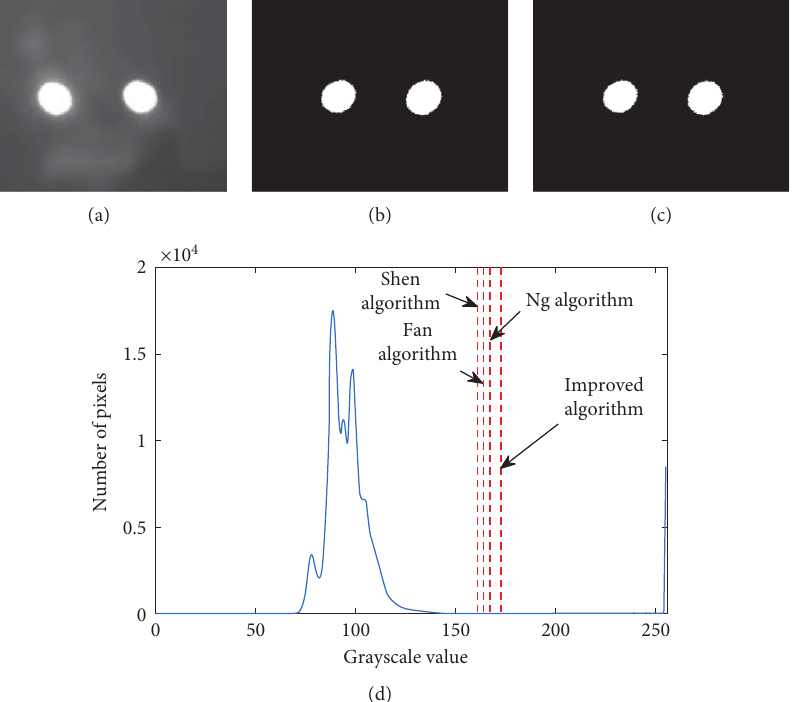
Figure 11: Laser spot segmentation effect without interference: (a) original image, (b) improved algorithm, (c) morphological processing, and (d) histogram and each segmentation threshold.